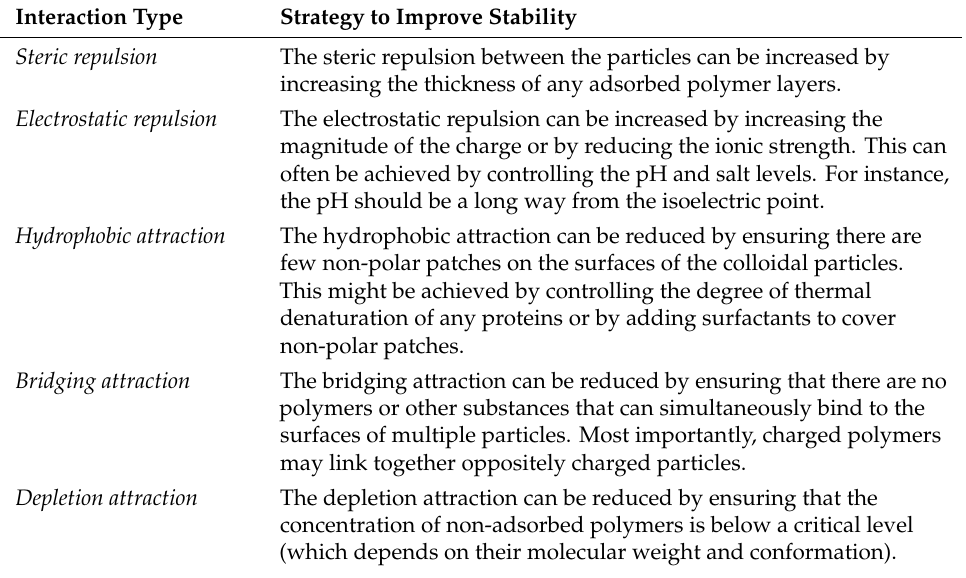
Table 2. Some common strategies for improving the aggregation stability of plant-based milks based on knowledge of the nature of colloidal